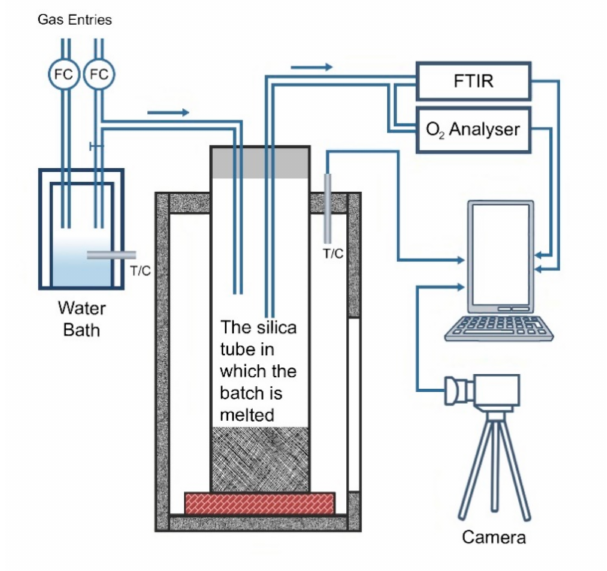
Figure 2. High Temperature Melting Observation